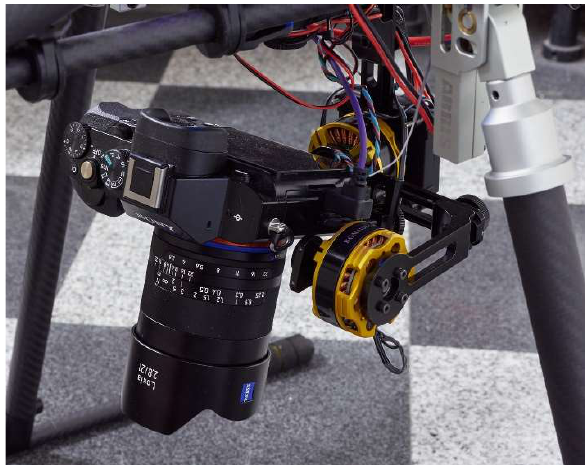
Figure 1. The 3-axis gimbal and the Sony Alpha 7R camera system with the Zeiss Loxia 2.8/21